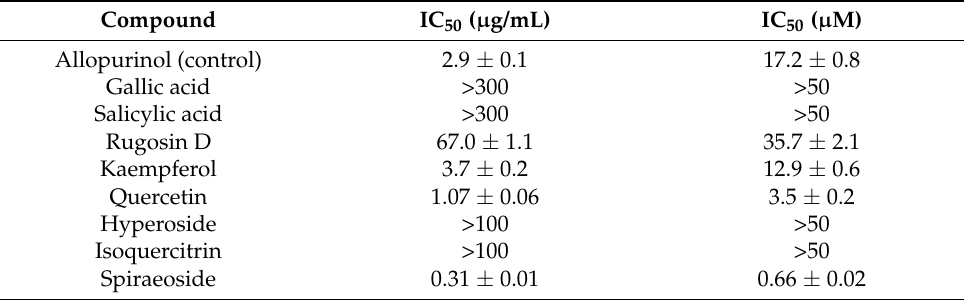
Table 2. IC 50 Values of purified compounds measured by UV spectroscopy. Compound IC 50 ( µ g/mL) IC 50 ( µ M) Allopurinol (control) 2.9 ±